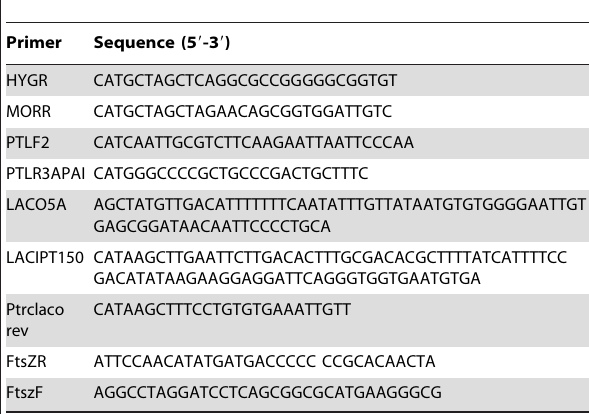
Table 3. Primers used in the present